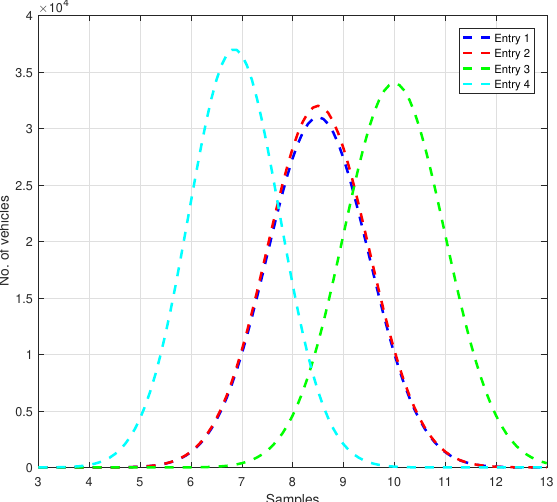
Figure 3. The rates of generation for the vehicles analysed during an entire